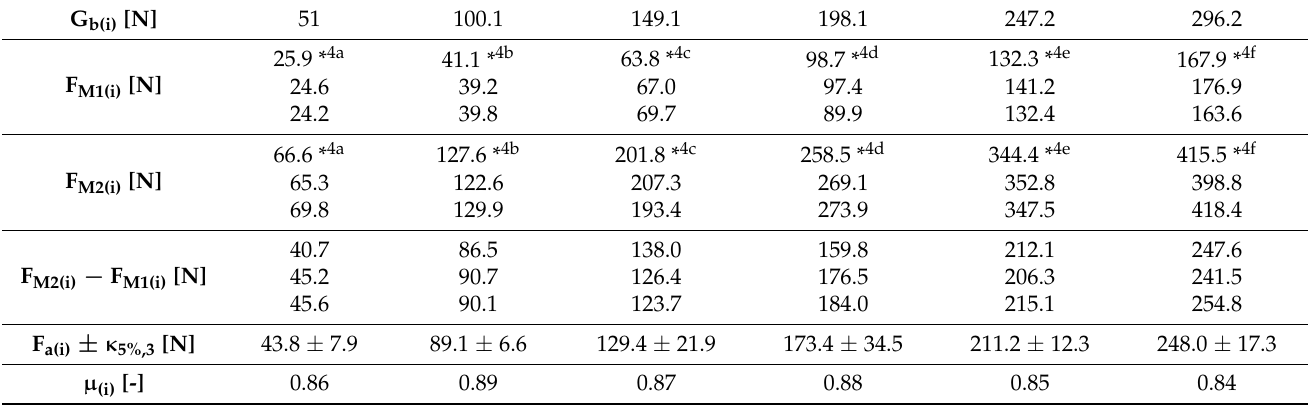
Table 5. Measured force F M1(i) [N] and F M2(i) [N] for the weight of the load G b(i) [N] at angle β = 30 deg.